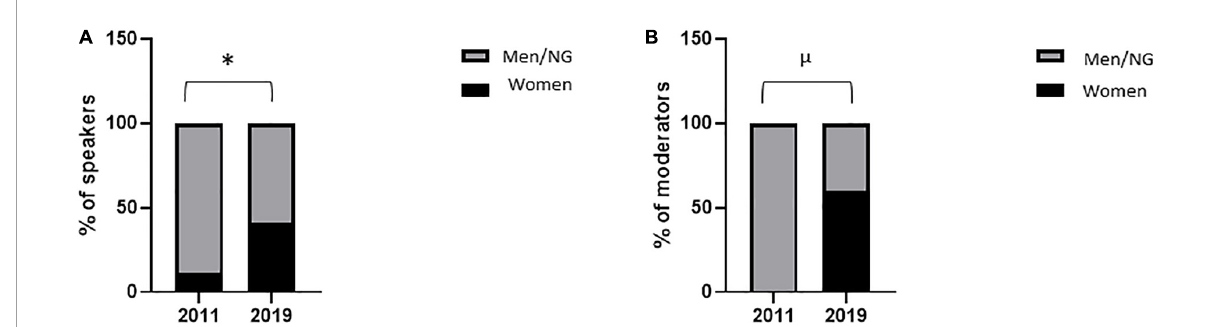
FIGURE3 Women speakers and moderators in symposia. Proportion of women speakers (A) and moderators (B) in industry-led symposia during the 2011 and 2019 congresses. Variables are presented as percentages. After contingency analysis, variables were compared by Fisher’s exact test. A p -value < 0.05 was considered significant. ∗ p = 0.05; µ p = 0.03. NG, non-gendered.